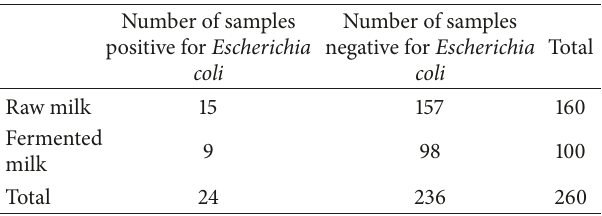
Table 2: Frequency of Escherichia coli isolates from raw and fermented milk samples.